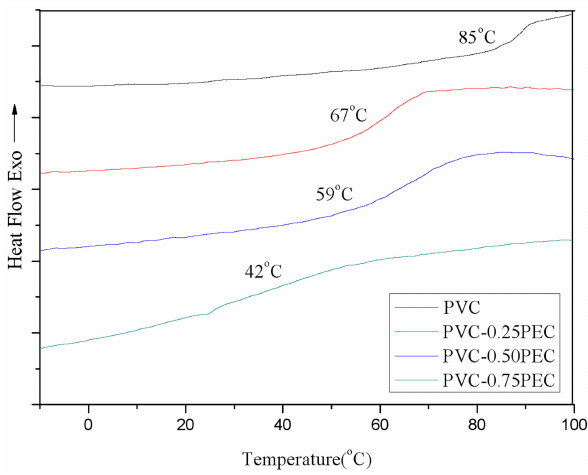
Figure 5. DSC curves of PVC and internally plasticized PVC